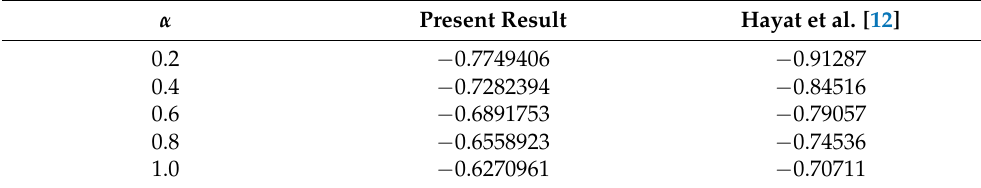
Table 4. Comparison of f (cid:48)(cid:48) ( 0 ) skin friction values for several fluid parameter α values.